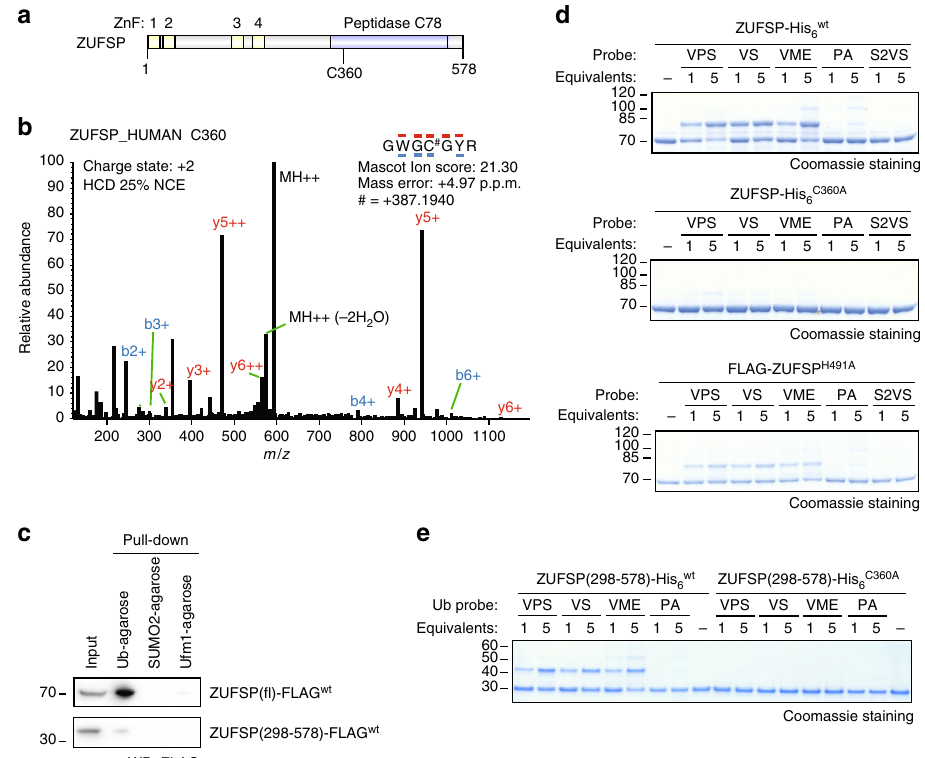
Fig. 5 ZUFSP interacts with ubiquitin and reacts with Ub ABPs. a Domain structure of ZUFSP. Domain prediction from SMART (http://smart.embl- heidelberg.de) 44 . Figure produced using Illustrator for Biological Sequences (http://ibs.biocuckoo.org) 70 . b A representative MS/MS spectrum showing a peptide-spectrum matched to ZUFSP Cys-360-labeled peptide sequence. c Pull-down of FLAG-ZUFSP by Ub, SUMO2, or UFM1-conjugated agarose. Lysates from FLAG-ZUFSP-overexpressing cells were enriched on the indicated resins and analyzed by anti-FLAG immunoblotting. d Reactivity of full- length ZUFSP toward ABPs. Puri fi ed ZUFSP (wt, C360A, or H491A mutant) was treated with the indicated ABP (Ub-VPS, Ub-VS, Ub-VME, Ub-PA, or SUMO2-VS [S2VS]), then analyzed by SDS-PAGE and stained with Coomassie Brilliant Blue. e Reactivity of the catalytic domain of ZUFSP toward ABPs. Puri fi ed ZUFSP(298 – 578) (wt or C360A mutant) was treated with ABP, then analyzed by SDS-PAGE, and stained with Coomassie Brilliant